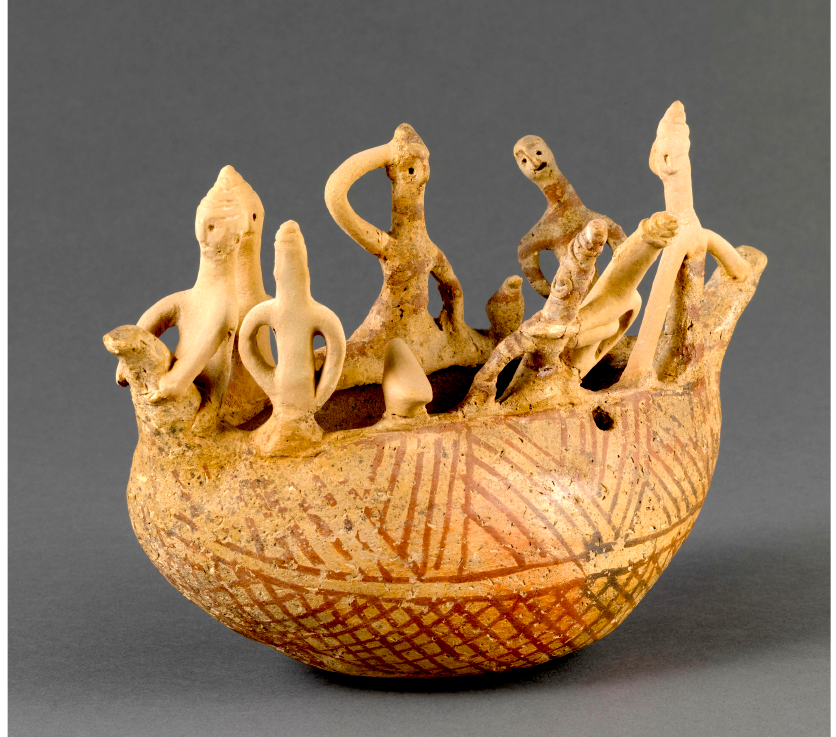
Figure 5. White Painted ware model of boat with crew, AM 972. Courtesy of the